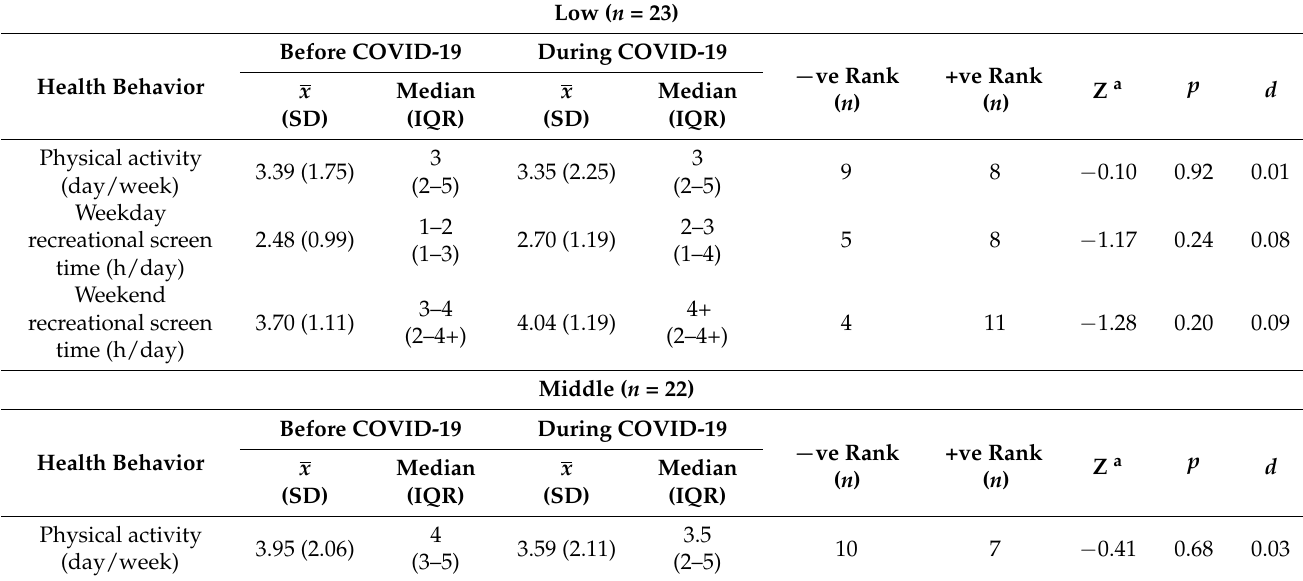
Table 4. Median family income differences in children’s physical activity and screen time from before to during